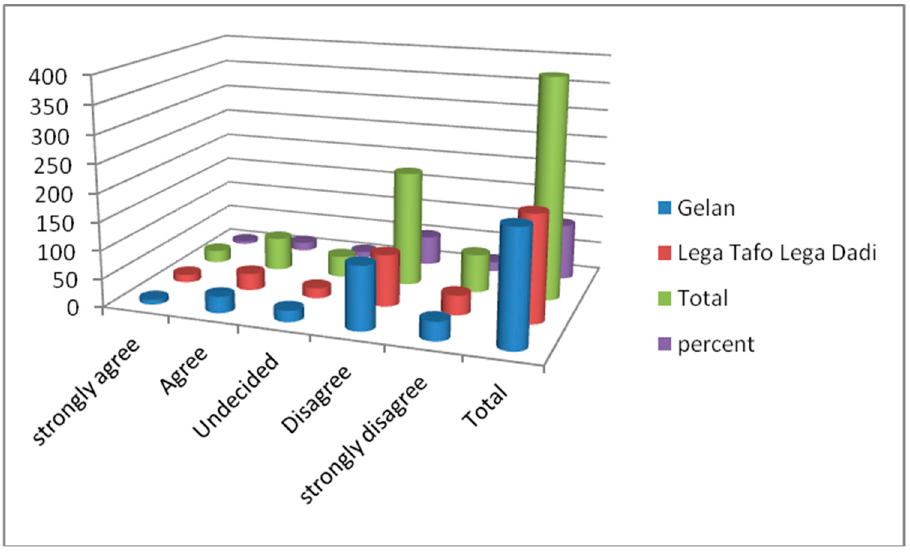
Figure 6. The response rates of household (HH) respondents on the availability of a credit market for the land of the towns (source: HH survey, 2022).